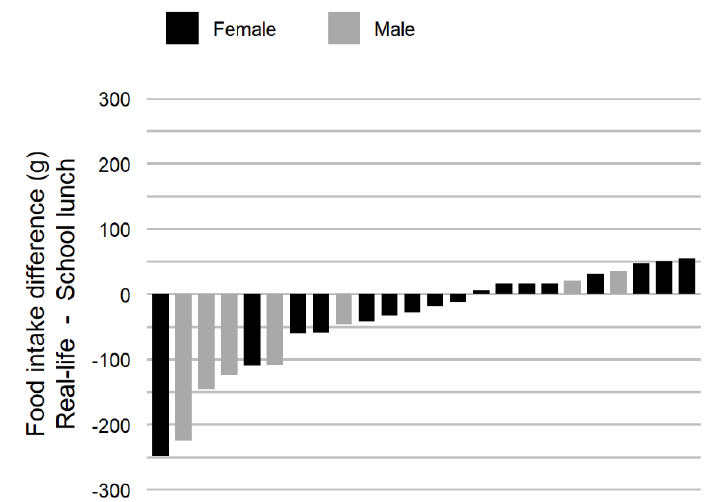
Figure 3. Food intake weight difference between the school lunch and the mean value of all real-life meals.